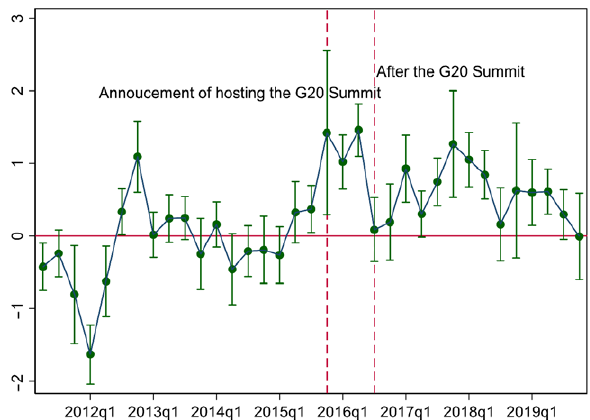
Figure 2. Parallel trend test (95% confidence intervals)